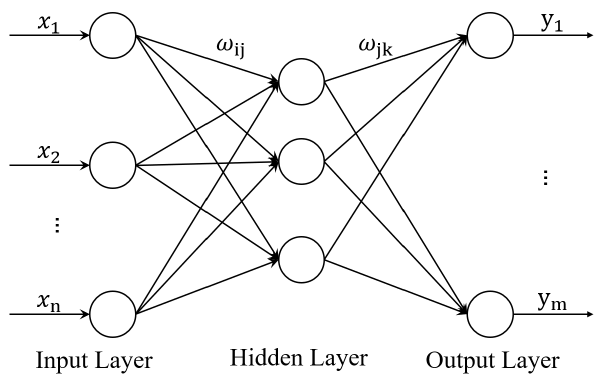
Figure 2. Principle diagram of BP